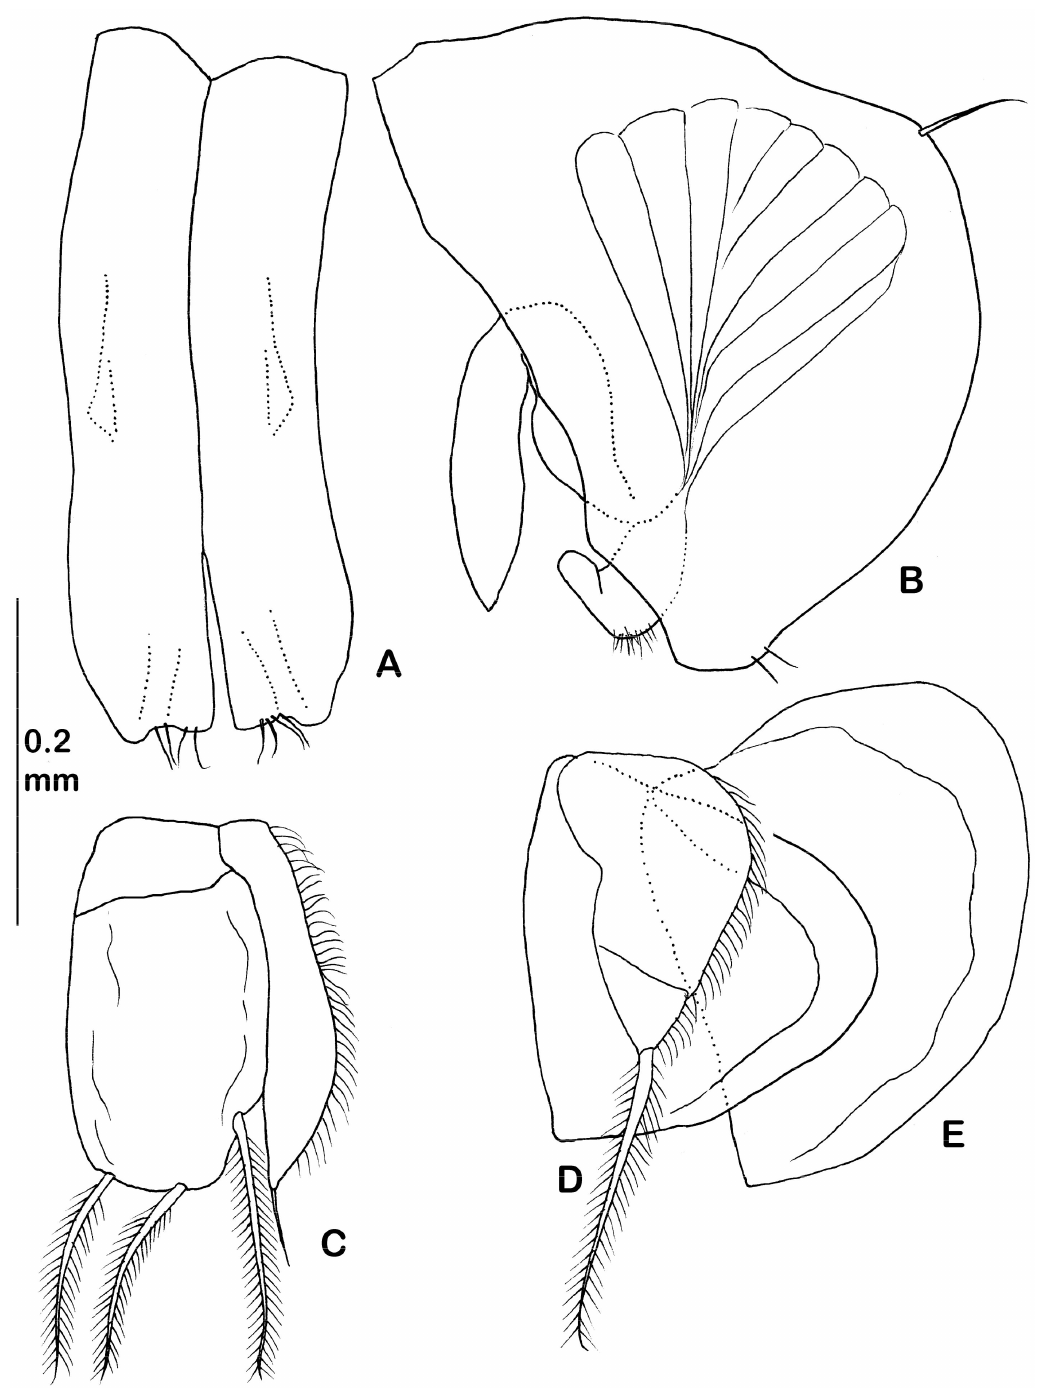
Figure 20. Eurycope nikitai sp. nov. Male paratype (ZMH K-45633): ( A ) pleopod I; ( B ) pleopod II; ( C ) pleopod III; ( D ) pleopod IV; ( E ) pleopod V. Pleopod IV (male paratype, ZMH K-45633, Figure 20D) endopod length 1.2 times width, exopod 0.8 times endopod length and 0.5 times endopod width. Stout plumose distal seta as long as exopod. Pleopod V (male paratype, ZMH K-45633, Figure 20E) length 1.2 times width, 1.15 times pleopod IV length. Uropod (male paratype, ZMH K-45633, Figure 19E) length 0.3 times pleotelson length; protopod broadening distally, length 0.95 times width, with two simple and six UB